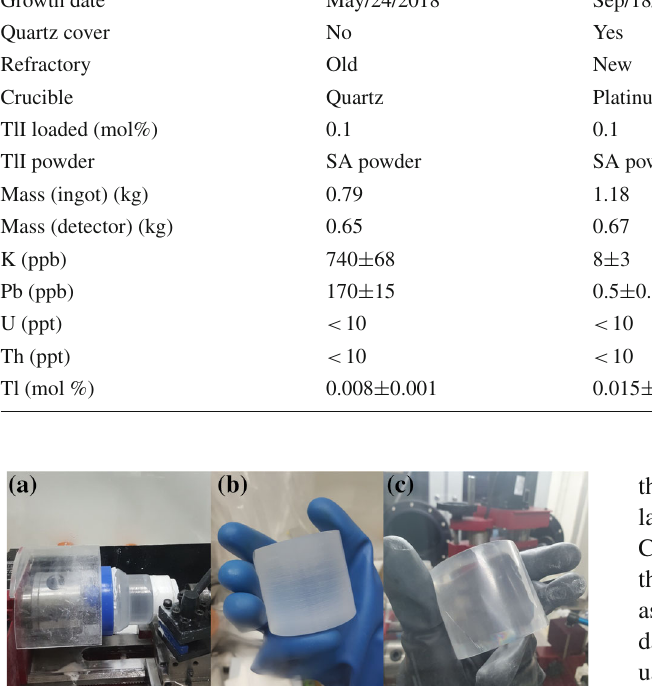
are coupled via an optical interface to each quartz window.